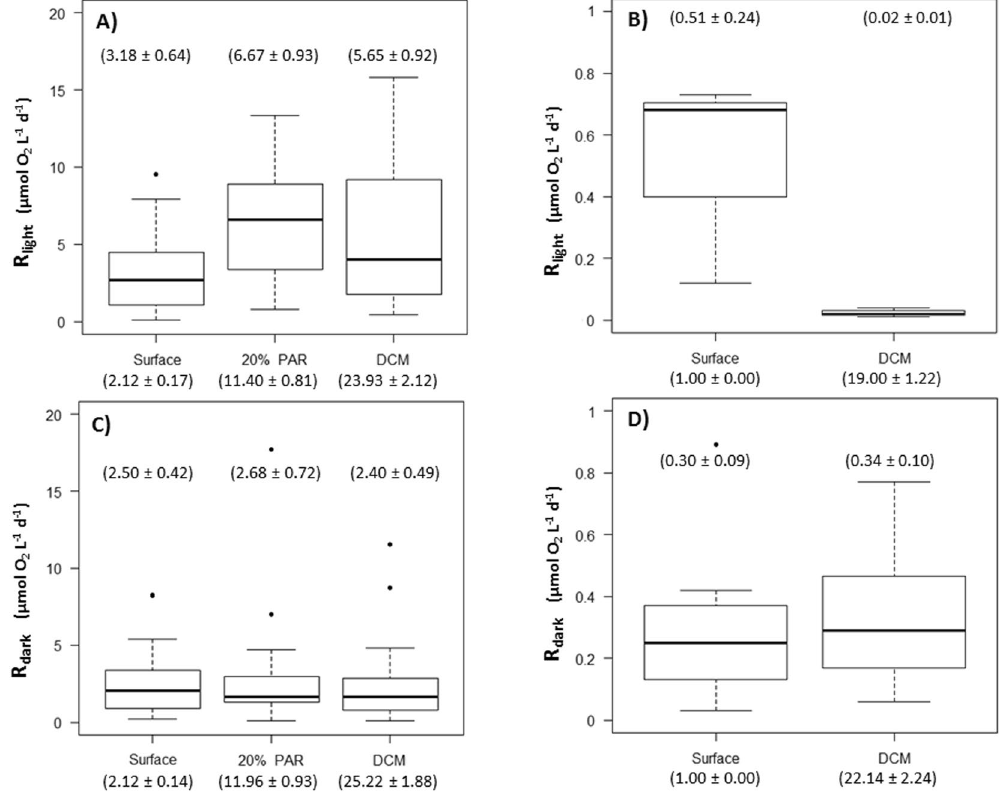
Figure 2. Box-and-Whisker plots showing the distribution of community respiration ( A ) in the light in Svalbard, ( B ) in the light in Young Sound, ( C ) in the dark in Svalbard and ( D ) in the dark in Young Sound, for the depths sampled (mean depth ± SE in parentheses). The boxes show the median rate plus the lower (25%) and upper (75%) quartiles, the whiskers indicate 1.5 times the interquartile range, and the points show outliers. Numbers above the boxes are the mean rates.